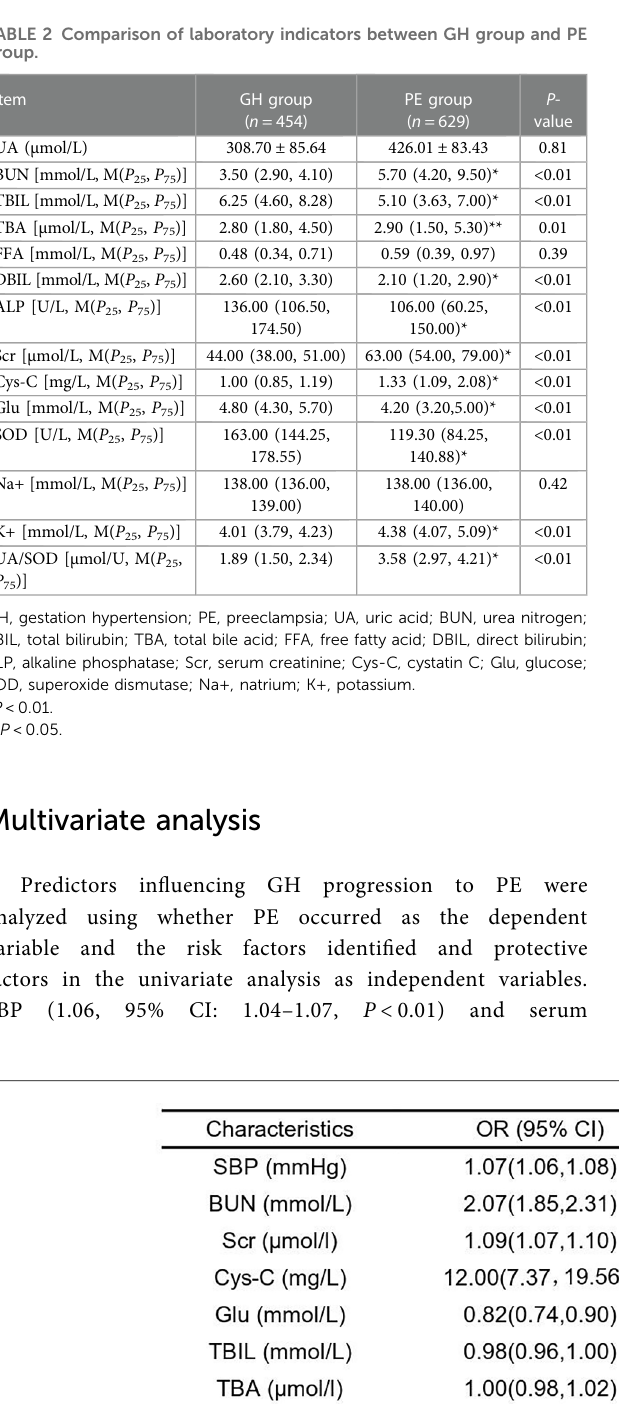
According to the results of the multivariate analysis, these 3 factors were included in the regression prediction model, and the calculation formula was: Y = − 21.99 + 0.05 × (SBP) +